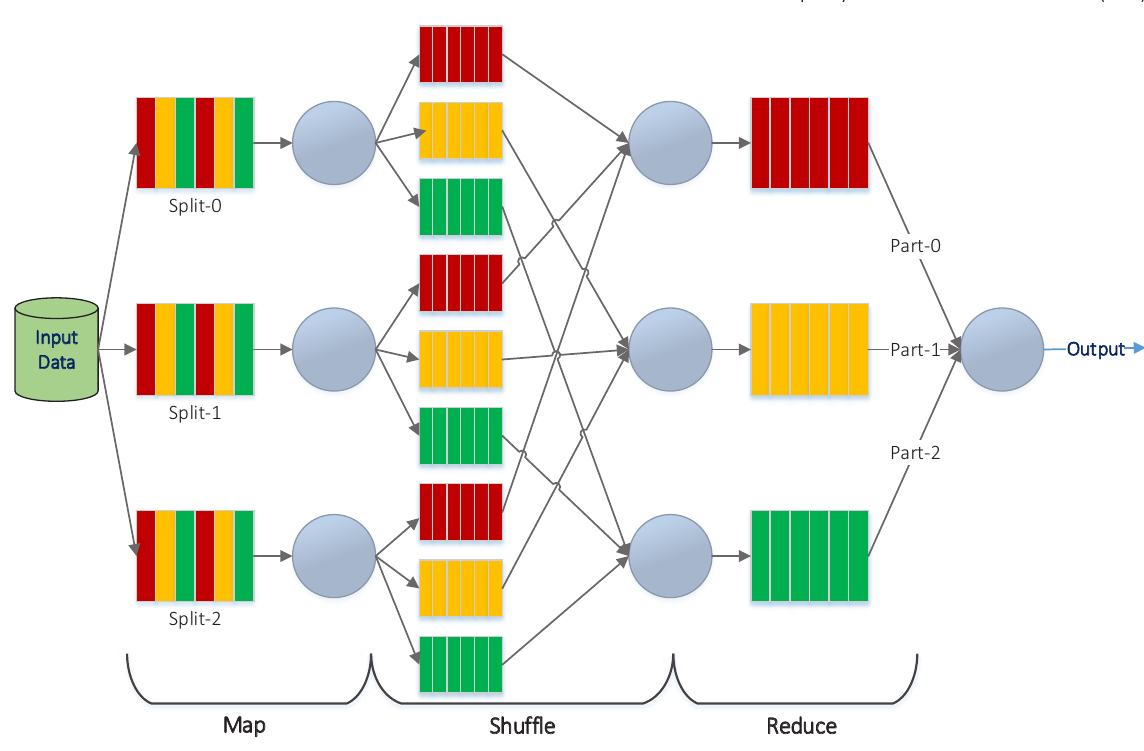
Figure 6. The basic flowchart of a MapReduce